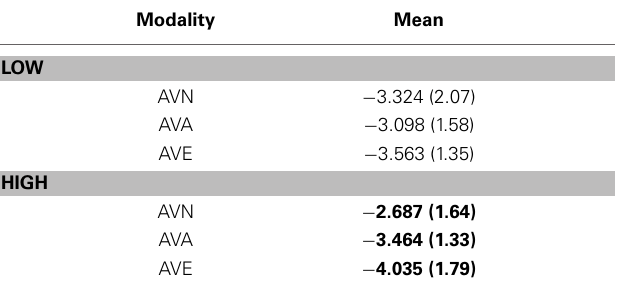
Table 7 | Means and standard deviations (in parentheses) of N100 amplitudes for frequent and deviant stimuli together, in the “emotional” bimodal-AVE, “animal” bimodal-AVA and “neutral” bimodal task-AVN, for each group.